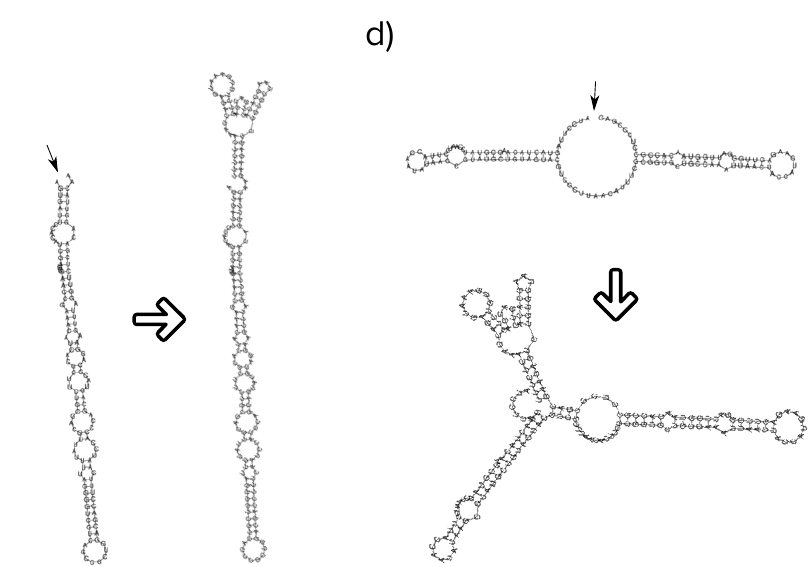
Figure 3. Effects of modular evolution in the structure of rod-like folds. Small arrows signal the recombination site; large arrows indicate the transformation of the structure upon recombination with the hammerhead. ( a ) Structure of the example hammerhead to be recombined with evolved sequences. ( b ) Part of the structure is maintained and part disrupted. The hammerhead structure is lost. ( c ) Both recombining structures are preserved. ( d ) The hammerhead structure is preserved, but the rod-like fold is partly